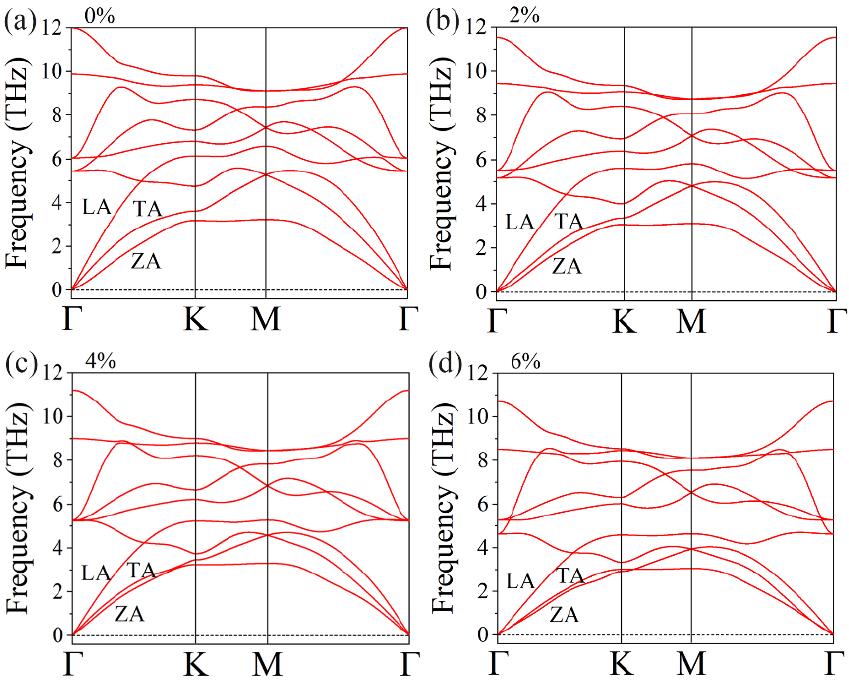
Figure 8. The phonon spectrum of GeS 2 monolayer under different biaxial tensile strains of ( a ) 0%, ( b ) 2%, ( c ) 4% and ( d ) 6%.